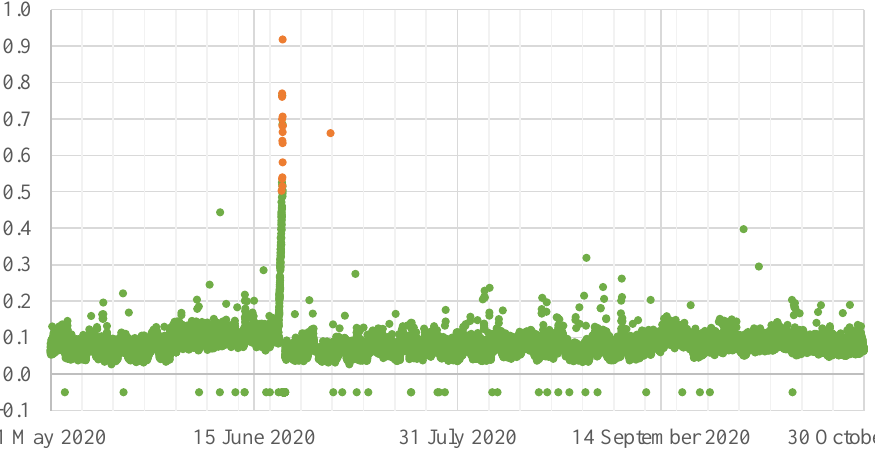
Figure 4. Global power quality index changeability for LV_HE.